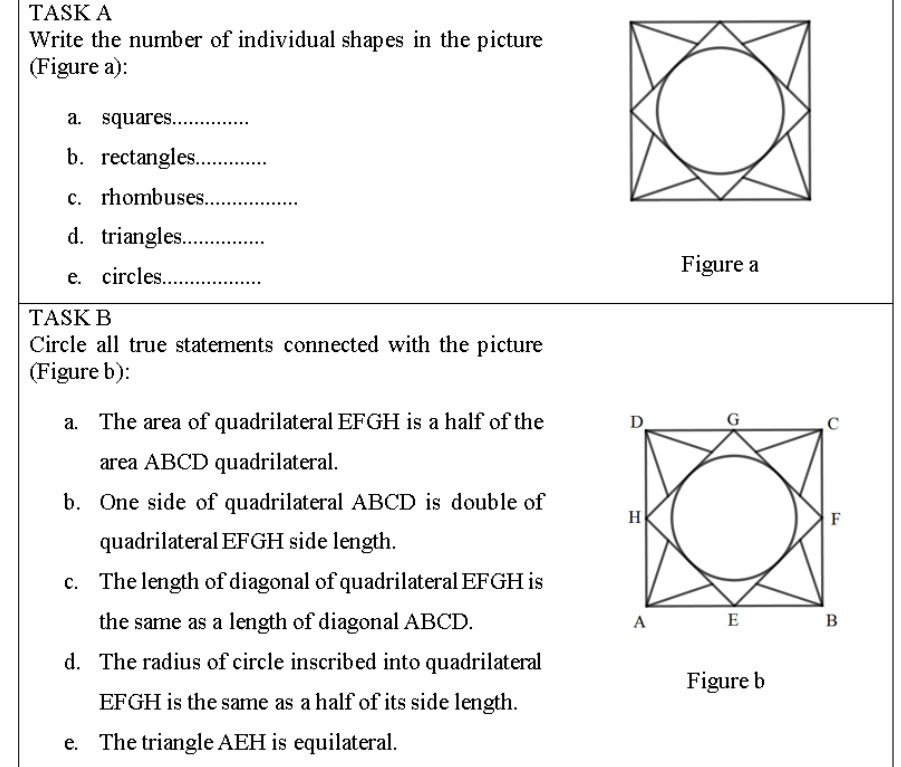
Figure 1. Research geometrical tasks.